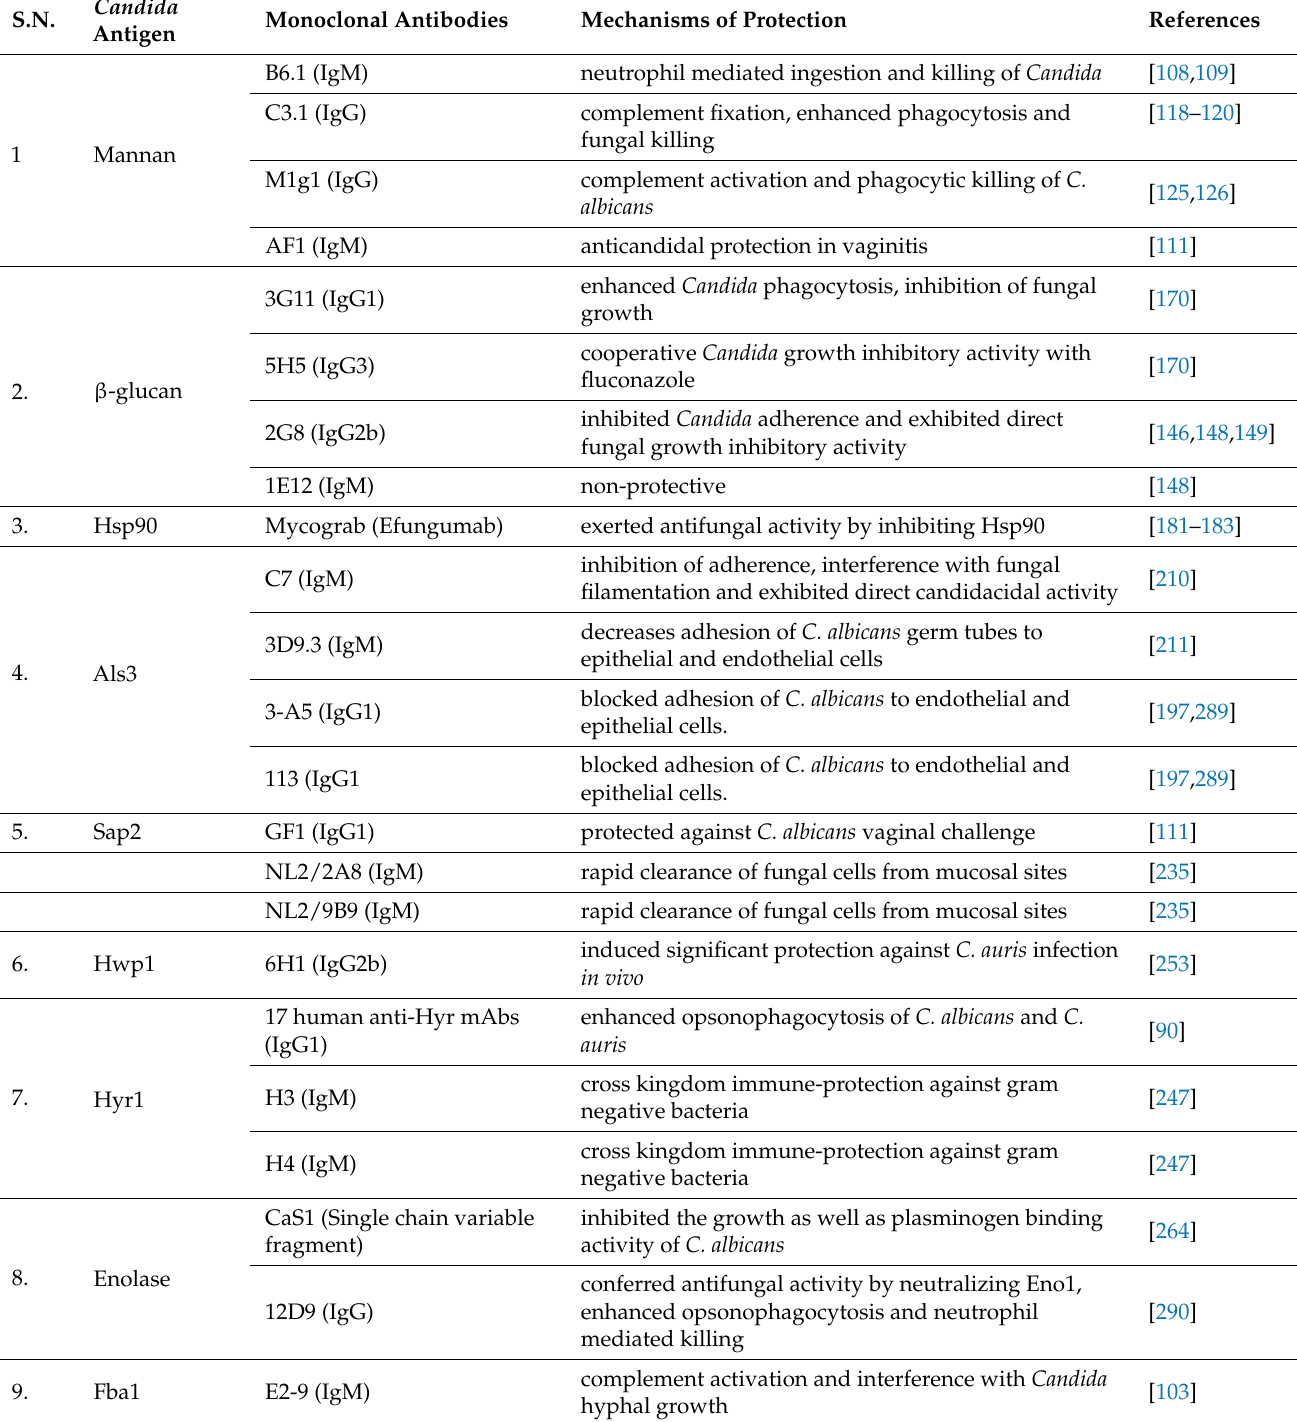
Table 2. List of protective monoclonal antibodies generated against Candida